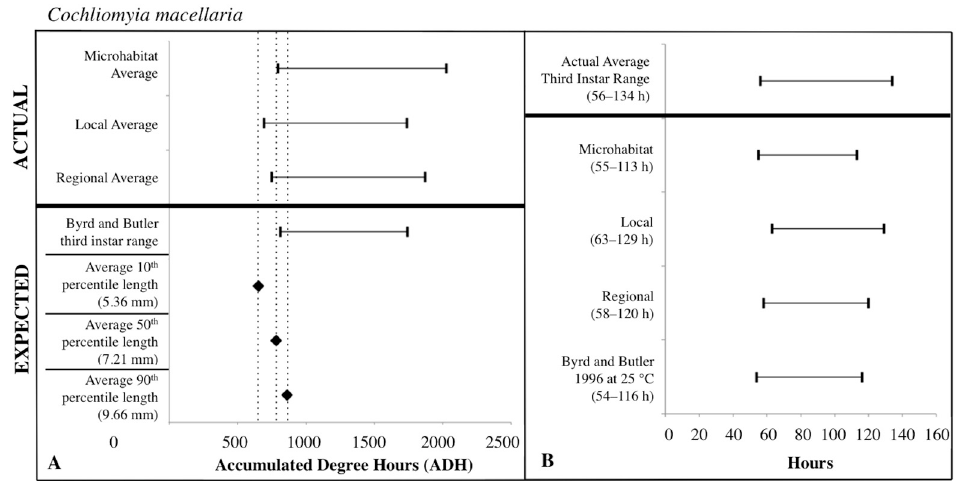
Figure 7. Comparison of expected accumulated degree hours (ADH) associated with Cochliomyia macellaria third instar developmental stage and length to actual third instar ADH ranges calculated for each temperature source: microhabitat, local, and regional. Actual ADH ranges represent the average range among carcasses. Black diamonds represent expected ADH values derived from 10 th , 50 th , and 90 th percentile third instar lengths ( A ). Comparison of the average Cochliomyia macellaria third instar post-colonization interval (PCI as hours) to estimated PCIs for each temperature source ( B ). For both A and B: thin horizontal lines with vertical ends represent minimum-maximum ranges and values above the thick black line are actual while those below are expected or estimated based on different temperature sources or development data set.